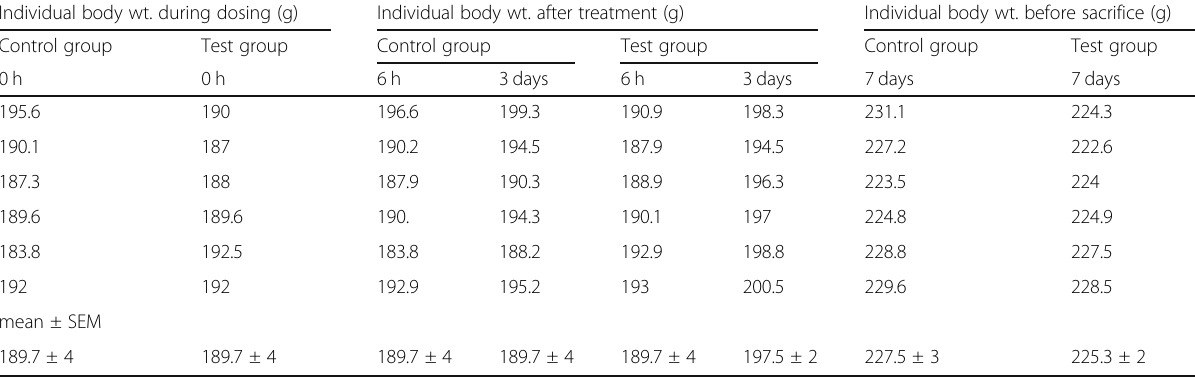
Table 1 Results showing the individual weights of animals treated with the EEPM (5000 mg/kg/b.w) fruits Individual body wt. during dosing (g) Individual body wt. after treatment (g) Control